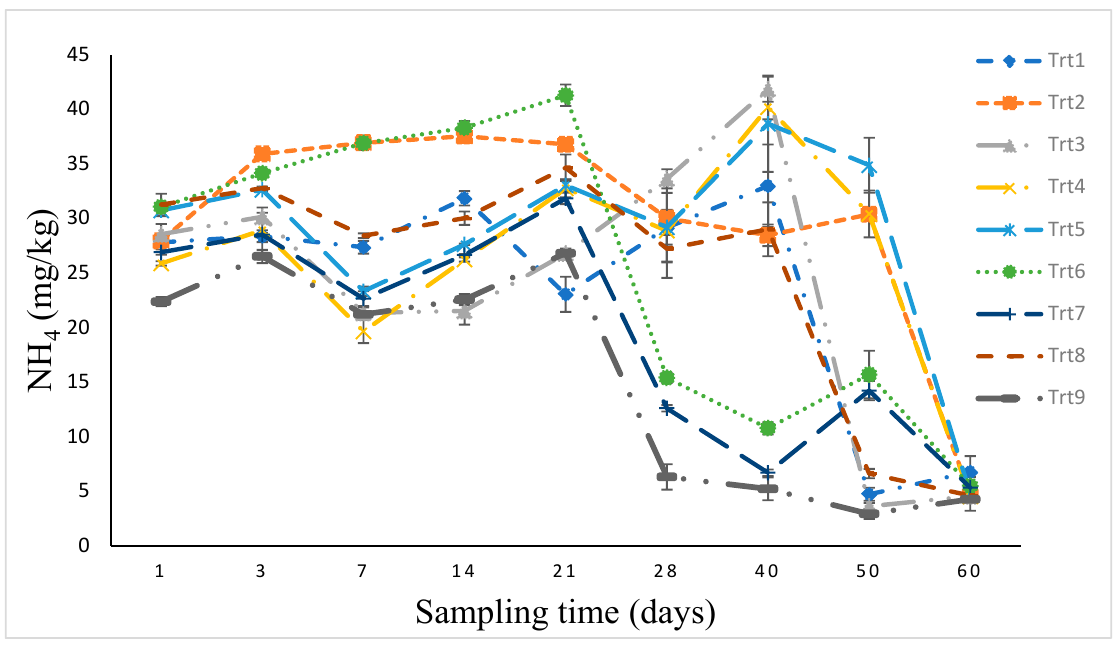
Figure 5. Ammonium nitrogen released in soils during incubation at different rates of compost application. Key: Trt1: 3:1 − IMO at 5 t ha − 1 , Trt2: 3:1 − IMO at 10 t ha − 1 , Trt3: 1:2 − IMO at 5 t ha − 1 , Trt4: 1:2 − IMO at 10 t ha − 1 , Trt5: 3:1 + IMO at 5 t ha − 1 , Trt6: 3:1 + IMO at 10 t ha − 1 , Trt7: 1:2 + IMO at